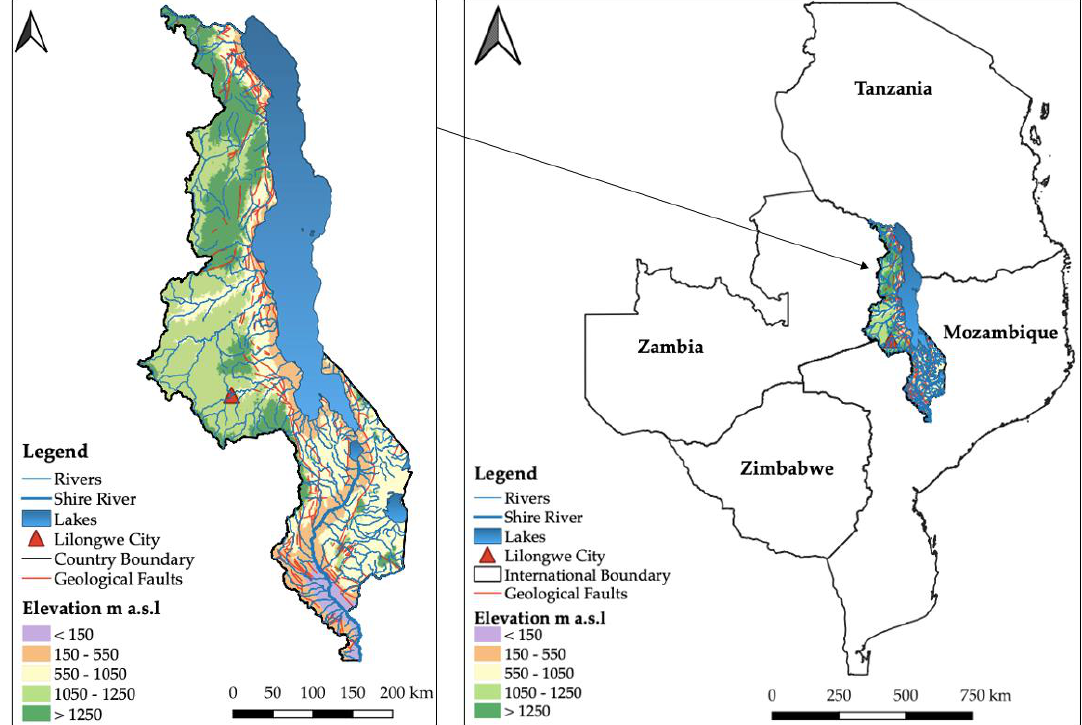
Figure 1. Study area showing topography (various colored zones), major rivers, lakes, fault lines and neighboring